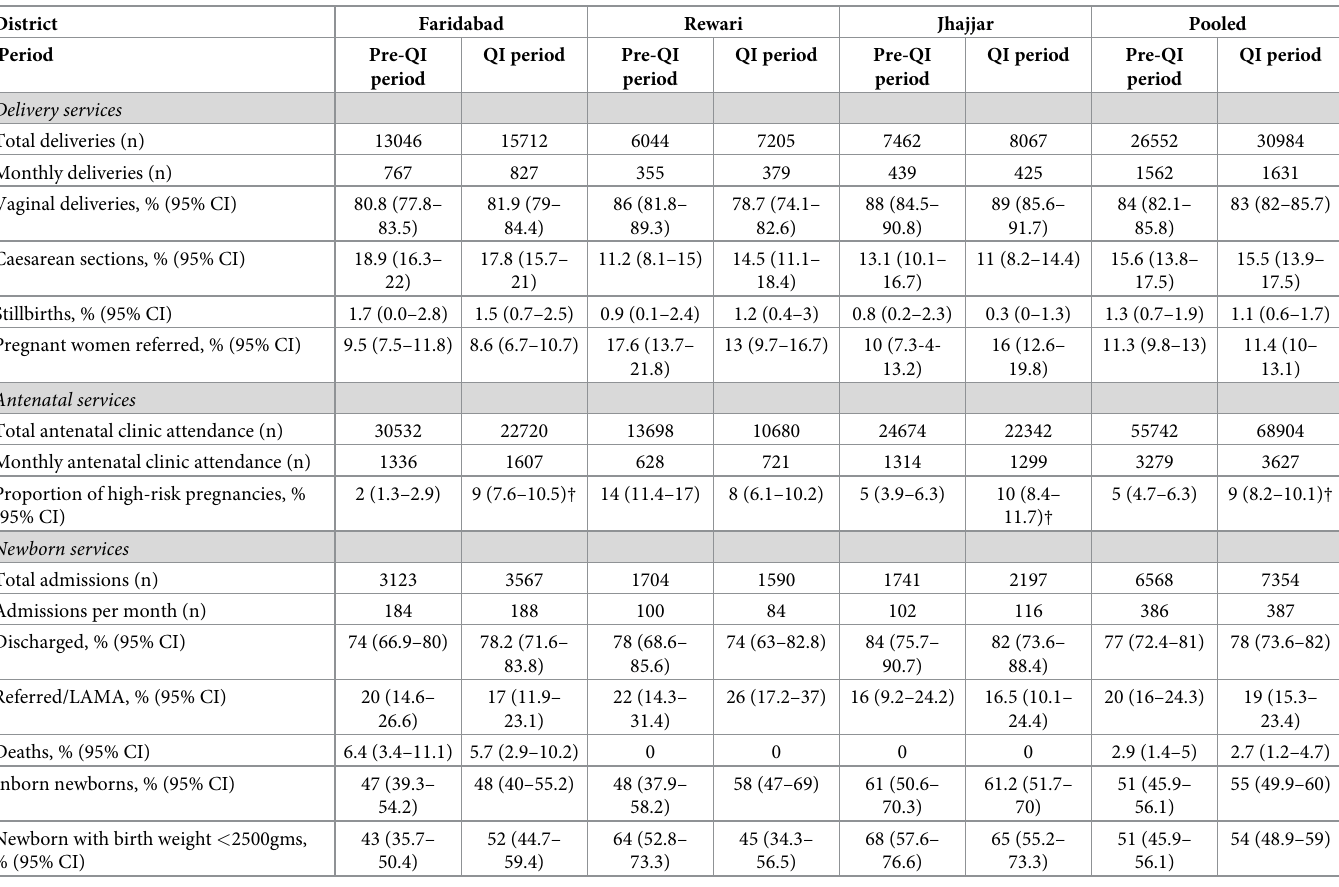
Table 3. Changes in the maternal and newborn service delivery indicators in the districts during the intervention period compared to the pre-intervention